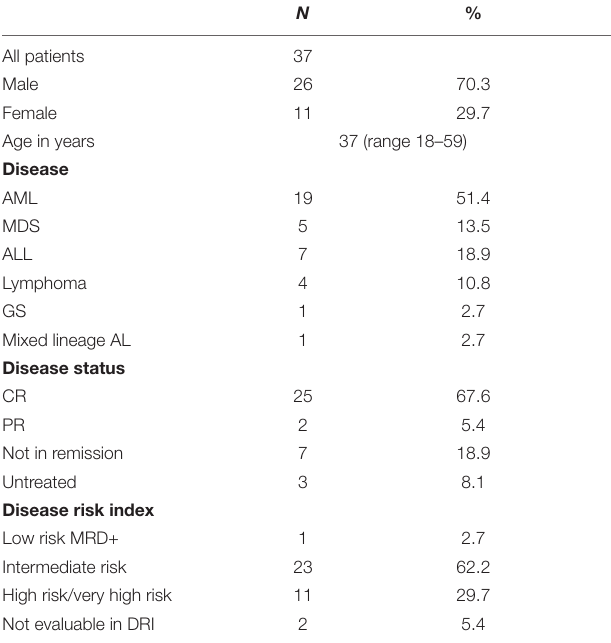
TABLE 1 | Patient characteristics.